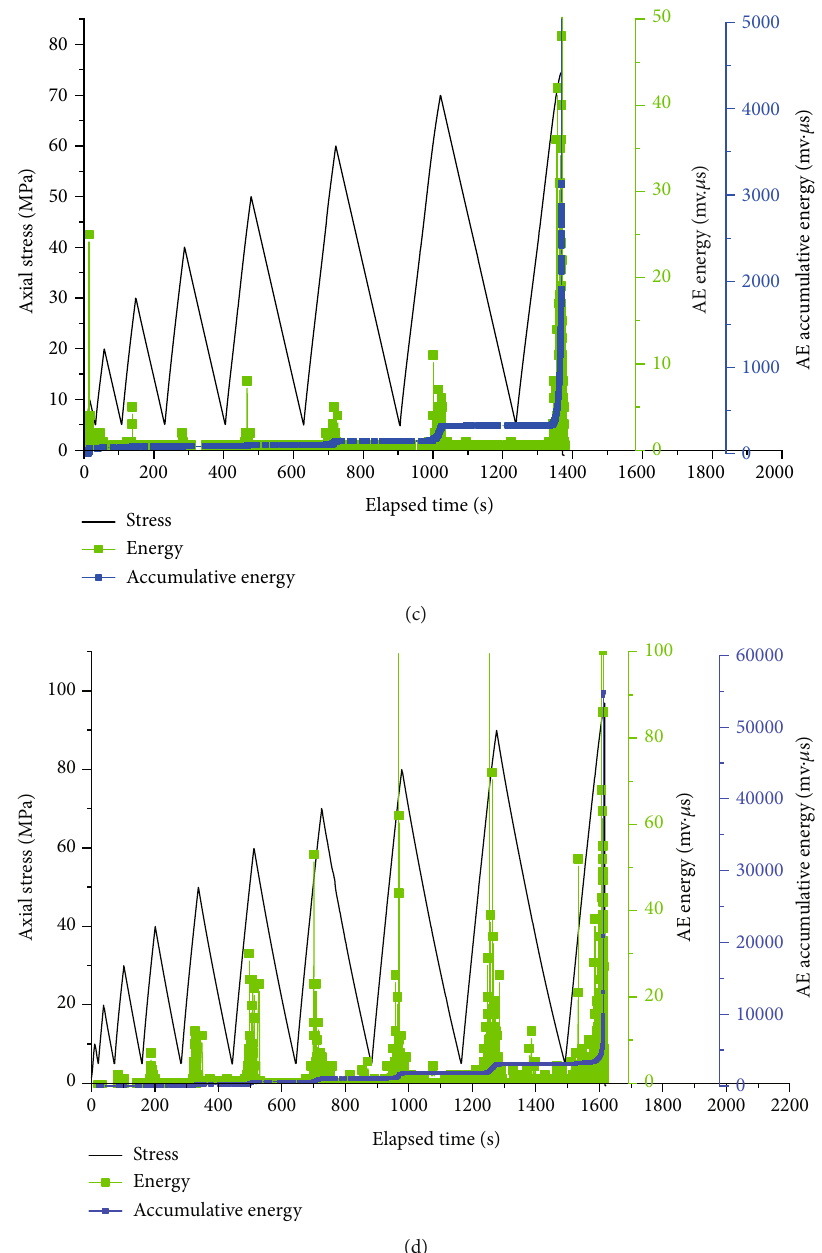
Figure 15: Output of AE energy for the tested granite samples. (a – d) It corresponds to samples of NFG-34, NFG-24, NFG-21, and NFG-30, and the corresponding natural fracture volume ratios are 0.19%, 0.15%, 0.13%, and 0.11%,